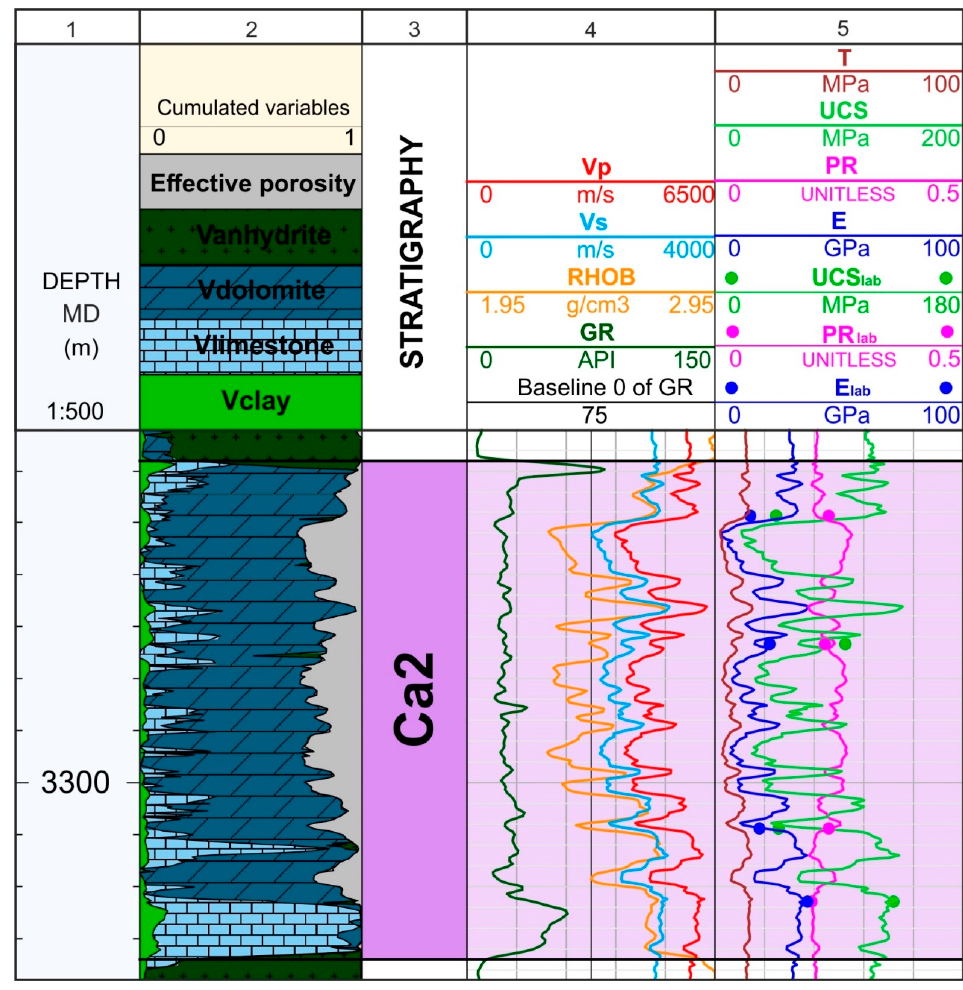
Figure 6. Graphic presentation of the input data and obtained 1D models of geomechanical pa- rameters: track: 1—measured depth, 2—mineralogical model, 3—stratigraphy, 4—The input data include the compressional wave (vp), shear wave velocity (vs), density (RHOB), gamma ray (GR), 5—1D model of static uniaxial compressive strength (UCS), static Poisson’s ratio (PR), and static Young’s modulus (E).